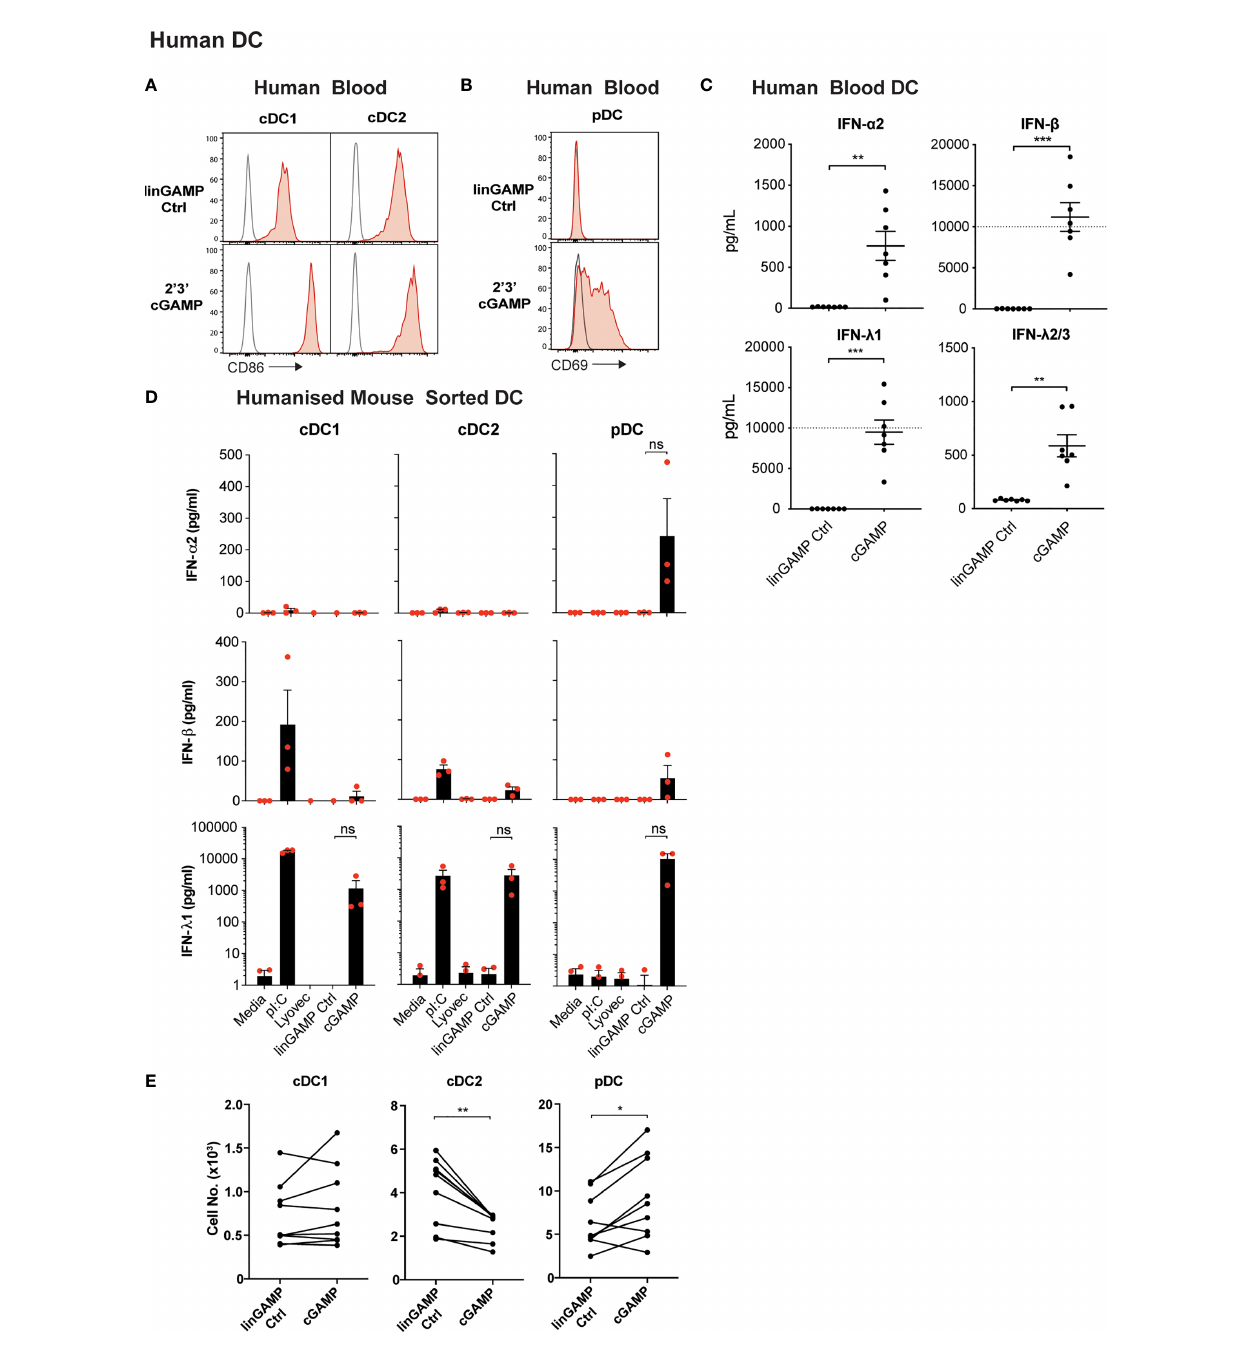
FIGURE 6 | Human DCs demonstrate potent activation and differential IFN production, but not pDC death, after cGAMP stimulation. (A – C) Human blood DCs were stimulated with 5 nmol 2 ’ 3 ’ cGAMP or its linearized control ligand (linGAMP Ctrl) complexed with lyovec for 18 hrs. Histograms show activation marker expression on human blood (A) cDCs or (B) pDCs. Grey un fi lled lines represent isotype control and red fi lled lines represent Ab stain. (C) Dots represent IFN production by DCs from each donor and lines show mean ± SEM of 7 donors from 3 independent experiments. Dotted line represents upper limit of quanti fi cation. (D) Sorted humanised mice DCs from BM were stimulated with 10 m g/mL pI:C, 10 nmol 2 ’ 3 ’ cGAMP or its linearized control ligand (linGAMP Ctrl) complexed with lyovec or lyovec alone for 18h. Bar graphs depict IFN production by each humanised mice DC subset showing mean ± SEM from 3 independent experiments. Human DC IFN production was analysed by fl ow cytometric bead assay. (E) Human blood DCs were stimulated with 5 nmol 2 ’ 3 ’ cGAMP or its linearized control ligand complexed with lyovec for 18 h and DC numbers enumerated by fl ow cytometry. Line graphs show paired individual cell numbers for each donor for each DC subset (n=9). Statistical analyses were performed using two-tailed Paired Student ’ s t test where *P < 0.05, **P < 0.01, ***P < 0.001 and ns, not signi fi